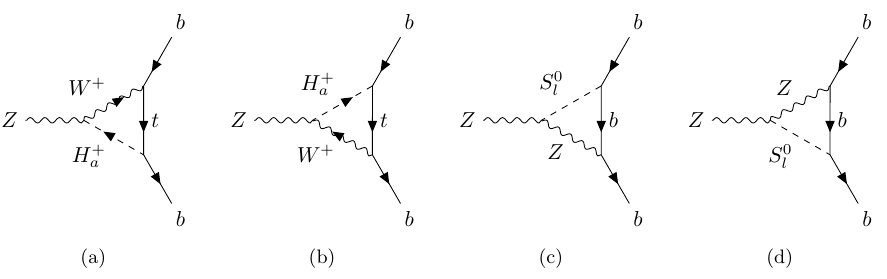
Figure 4 . Feynman diagrams that do not contribute to δg L and δg R in the specific case of this